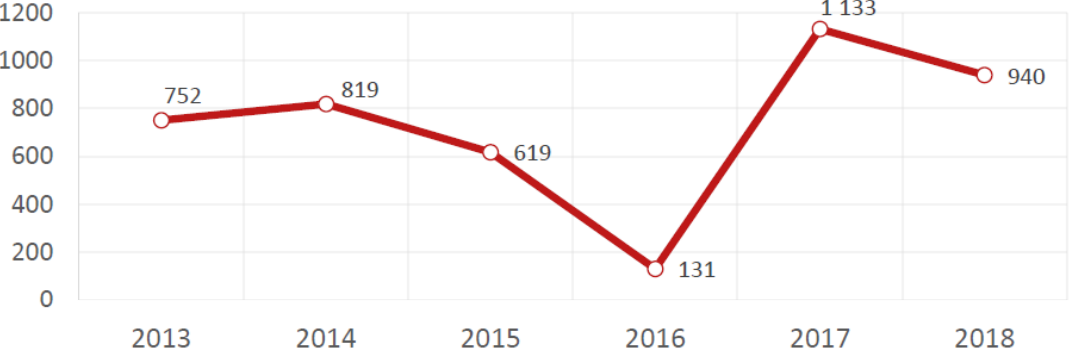
Figure 10: Movement on account retained earnings of STRABAG (in millions of CZK), (source: Annual report of STRABAG 2014-2018, data processed by the authors)